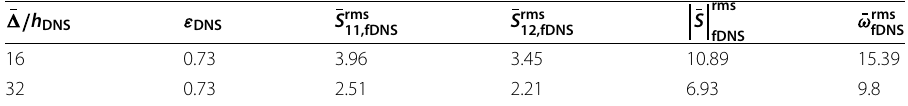
Table 6 The physical variables calculated using the filtered DNS data used for the variable normalization at the filter scales 16 h DNS and 32 h DNS h DNS